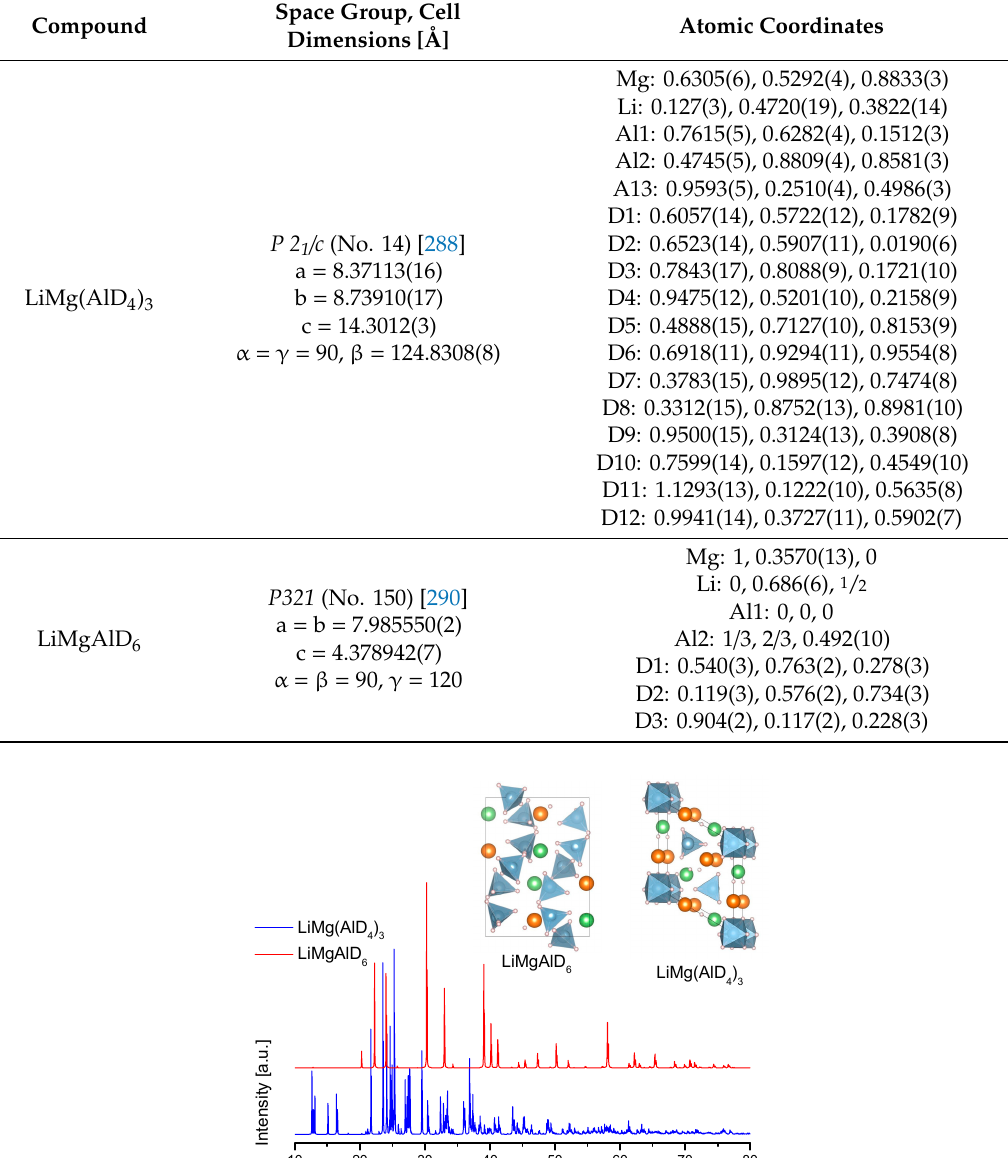
Table 16. Crystallographic data of Li-Mg mixed alanates.